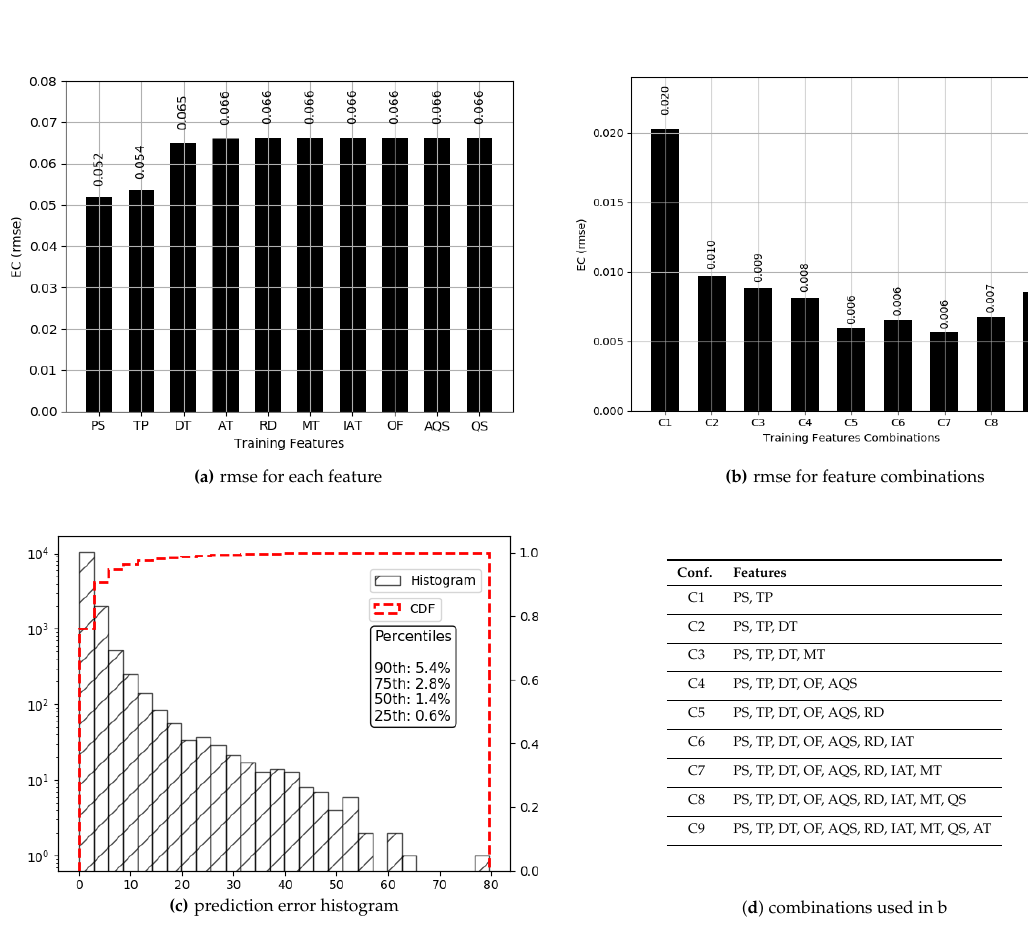
Figure 9. Prediction results for EC dense